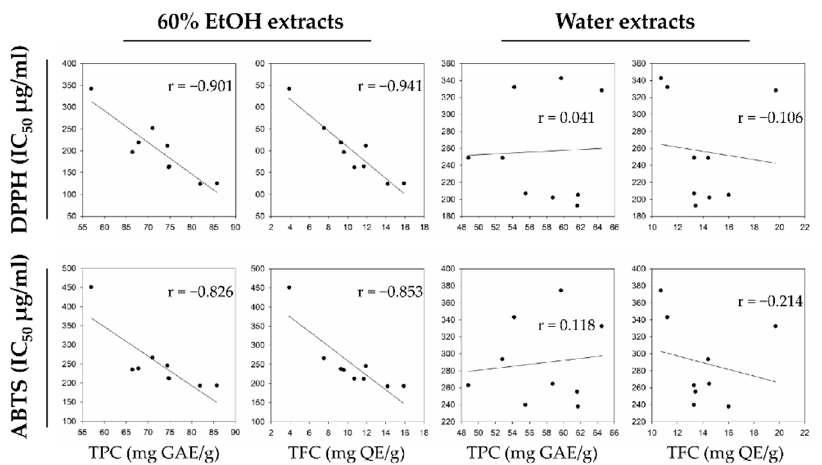
Figure 3. Scatter plot with Pearson correlation of relationship between antioxidant activities and phenolic compounds.